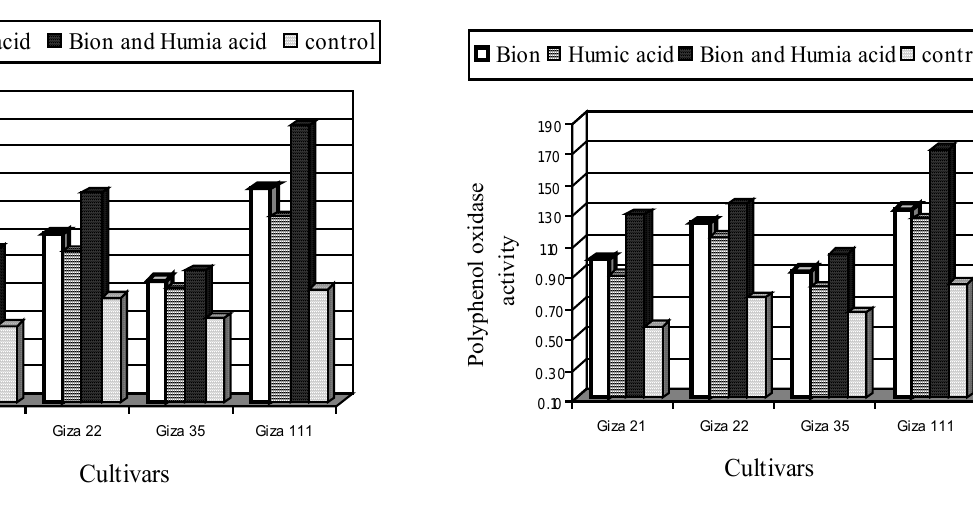
Fig. 2. Activity of peroxidase enzyme (enzyme unit mg protein -1 min -1 ) of four soybean cultivars as affected by BHT (0.5 g/l), HA (4 g/l) individually or combination (0.25+4 g/l).